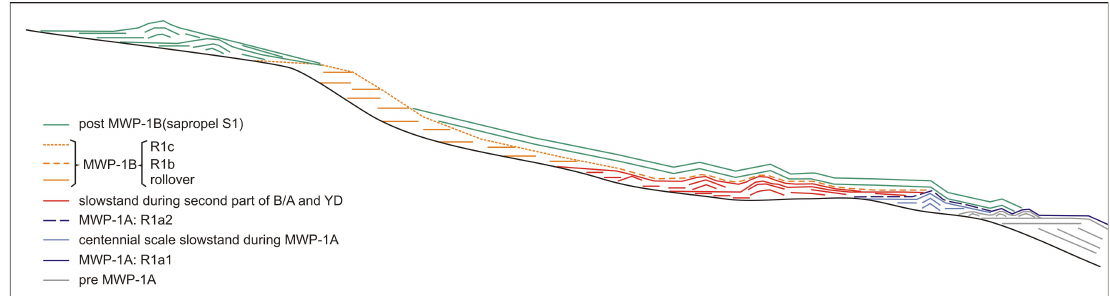
Figure 16. General model of transgressive architecture and stratal pattern of transgressive deposits recognised in the study area. Each colour corresponds to a phase of the